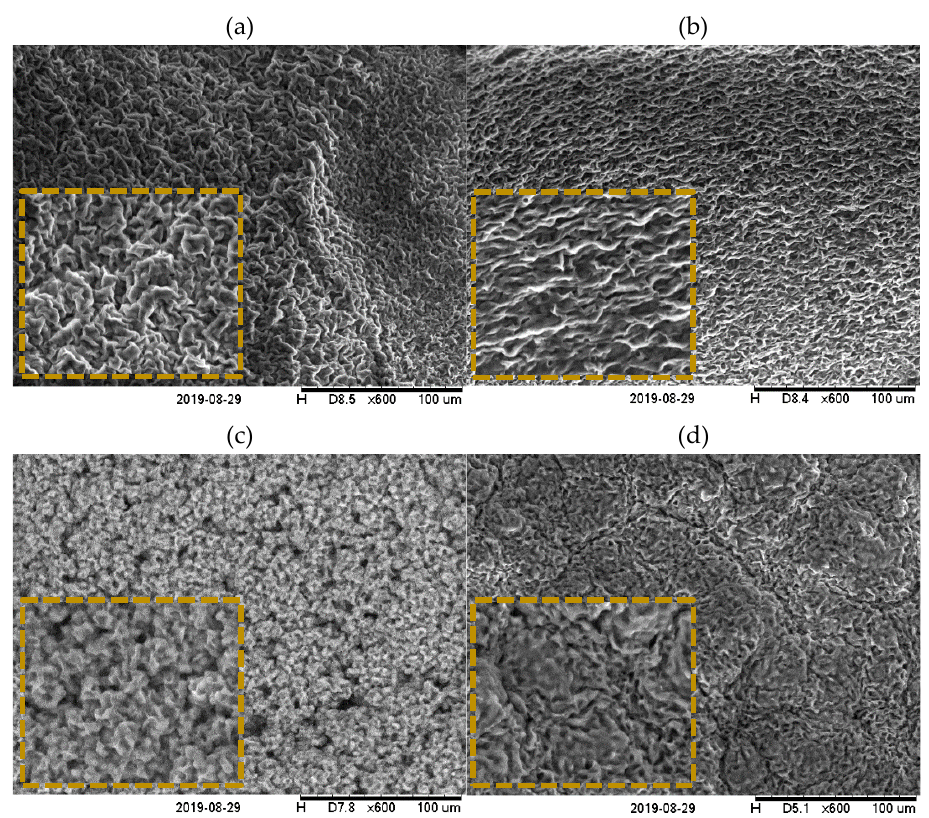
Figure 6. Scanning electronic microscopy (SEM) images of GMS0:100BEW ( a ), GMS25:75BEW ( b ), GMS25:75SHW ( c ), and GMS50:50SHW ( d ) oleogels. Magnification of 600×. Scale equivalent to 100 μm. The inset figures correspond to 1000 × magnification.